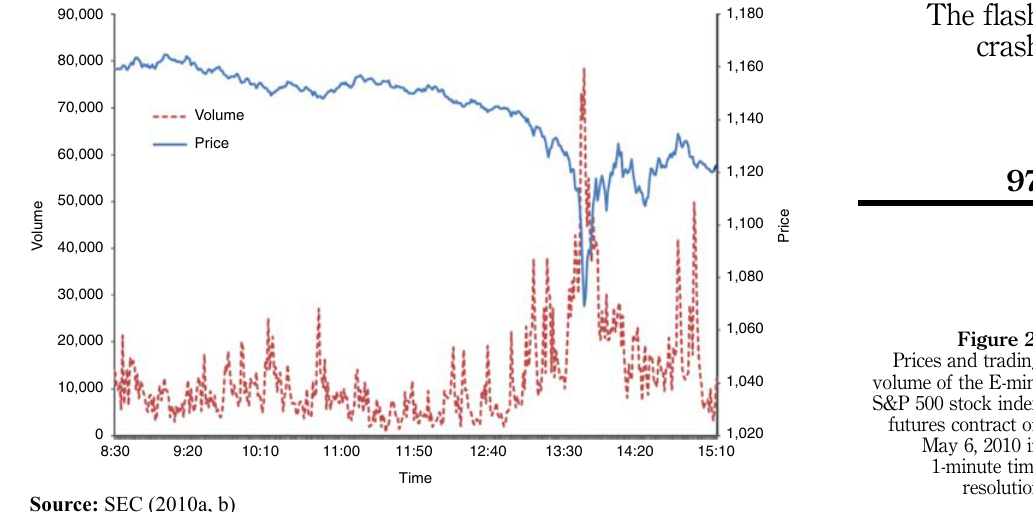
Figure 2. Prices and